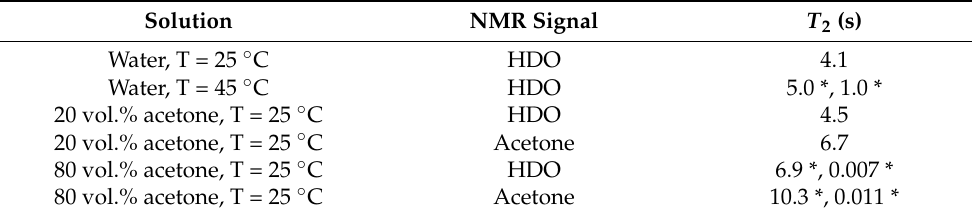
Table 1. Spin–spin relaxation times T 2 of water (HDO) and acetone protons measured for various solutions with the DN-DA